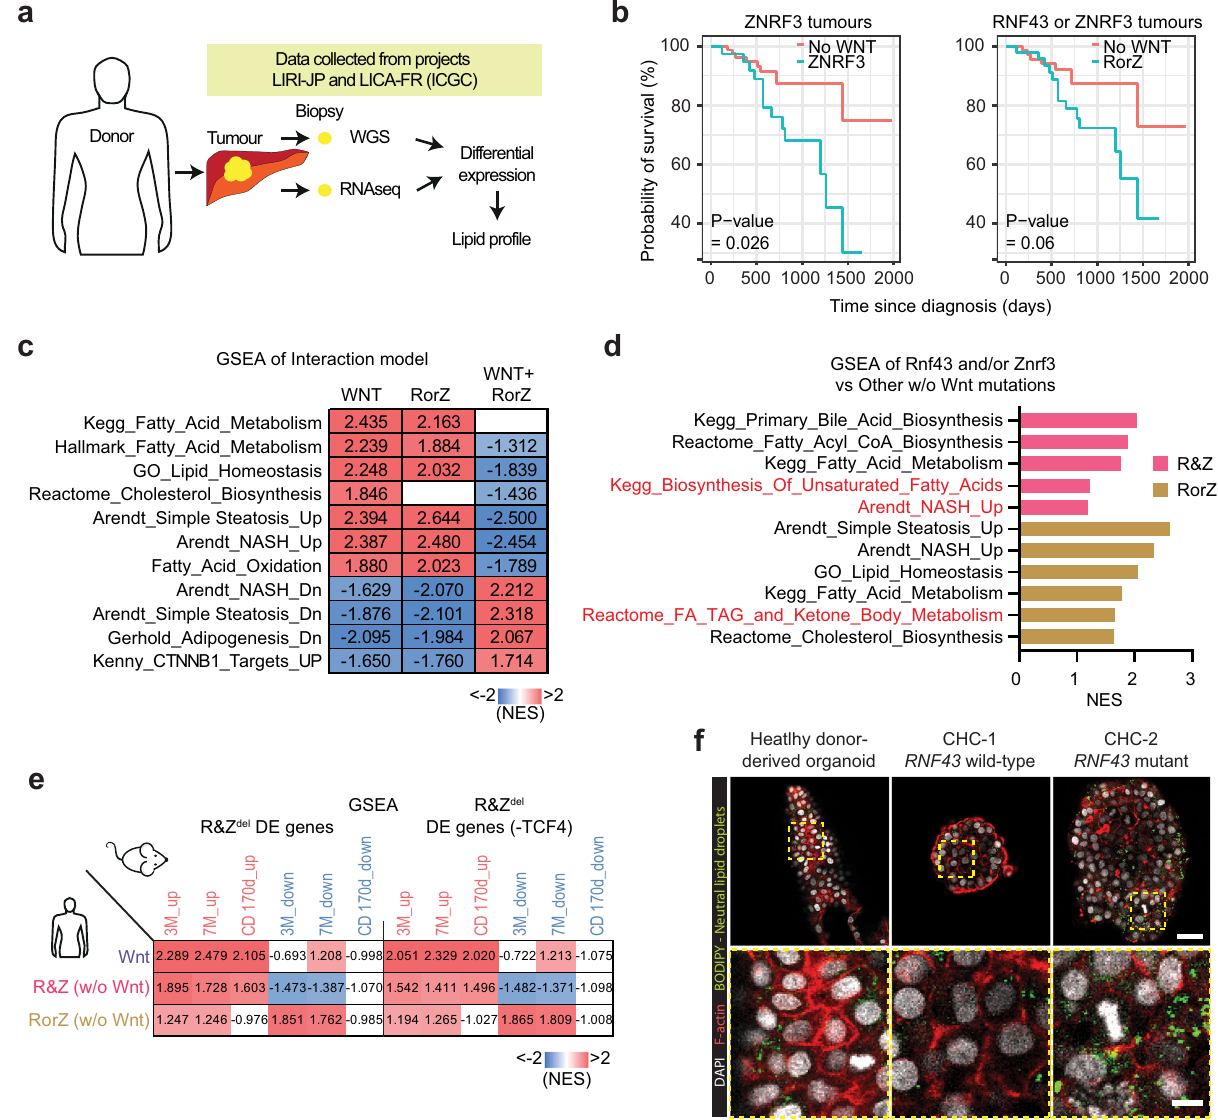
Fig. 7 Human HCC patients mutated in RNF43 and/or ZNRF3 present lipid metabolic alterations and poor prognosis. a – e Clinical data, whole genomic sequencing and RNAseq data were downloaded from ICGC database and used to determine the prognosis and expression pattern of human tumours mutated in RNF43 and/or ZNRF3 or other WNT pathway components ( APC , AXIN1 or CTNNB1 ). Full details in “ Methods ” , Supplementary Fig. 8 and Supplementary Data 6. a Experimental design. b Survival analysis after Cox proportional hazards model found a signi fi cant interaction with gender, tumour stage and WNT mutation status. All covariates passed the proportional hazards test except WNT mutation. The graph shows the survival analysis of HCC patients with ZNRF3 (ZNRF3, left) or RNF43 or ZNRF3 (RorZ, right) mutations compared to patients with no-WNT mutations (No-WNT). p Values obtained by Wald statistic, CI 95%. c , d Differential gene expression for patients with RorZ and R&Z mutations compared to non-WNT mutants (other w/o Wnt mutation). c A multiple regression model indicated an interaction between WNT mutation status and the signatures of RNF43 or ZNRF3 patients. Note that the presence of WNT mutation (WNT + RorZ) negatively impacts the expression of RorZ patients, with gene sets positively enriched in RorZ mutants becoming negatively enriched. d Signi fi cantly enriched ( p value <0.05, two-sided permutation test) gene sets in R&Z and RorZ-mutated patients compared to patients with no-WNT mutations. e Comparison between the mouse differentially expressed genes including or excluding TCF4 targets and the signatures of patients with mutations in R&Z, RorZ and WNT ( APC , CTNNB1 or AXIN1 ). The table represents the GSEA (NES) of the DE genes in R&Z del (3 and 7 months homeostasis or 170 days after damage, including or excluding TCF4 targets) against WNT, R&Z or RorZ human liver tumour signatures. NES scores are presented as a heatmap where red is positively enriched and blue is negatively enriched. Note the signi fi cant correlation. f Human liver organoids from healthy donors or patients with liver cancer (mixed subtype, CHC and mutations or not in RNF43) were grown and stained for neutral lipids (Bodipy, Green). Representative images from n = 2 independent experiments. Red, F-actin staining. White, Dapi. Scale bar, 60 μ m (top panel); 15 μ m (bottom